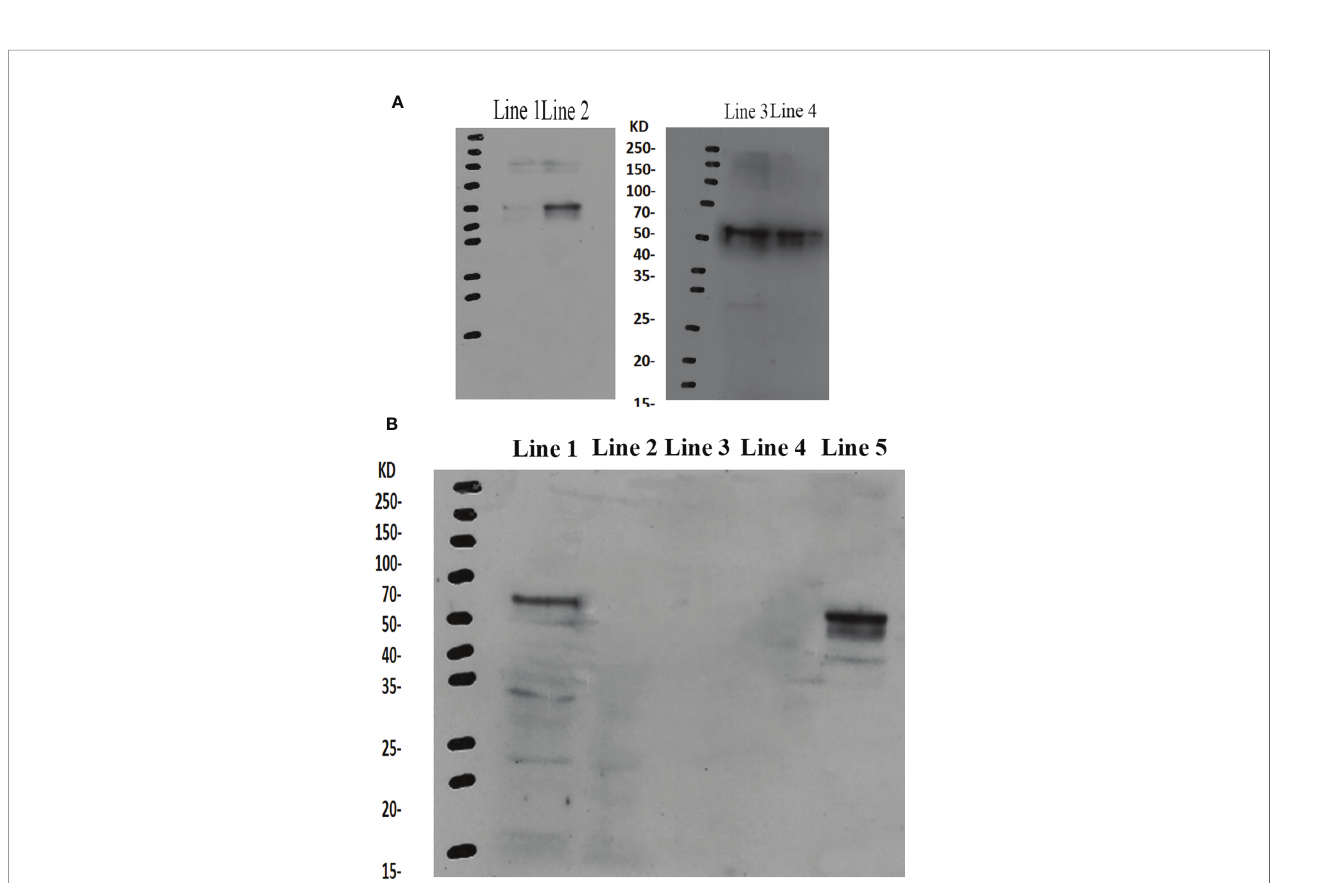
FIGURE 6 | (A) Western-blot analysis of Mn-PDHE1 in the testis and androgenic gland from the reproductive season and non-reproductive season. Line 1: Testis from the non-reproductive season; Line 2: Testis from the reproductive season; Line 3: Androgenic gland from reproductive season; Line 4: Androgenic gland from the non-reproductive season. (B) Western-blot analysis of Mn-PDHE1 in the different ovarian developmental stages. Line 1: Ovarian developmental stage I; Line 2: Ovarian developmental stage II; Line 3: Ovarian developmental stage III; Line 4: Ovarian developmental stage IV; Line 5: Ovarian developmental stage